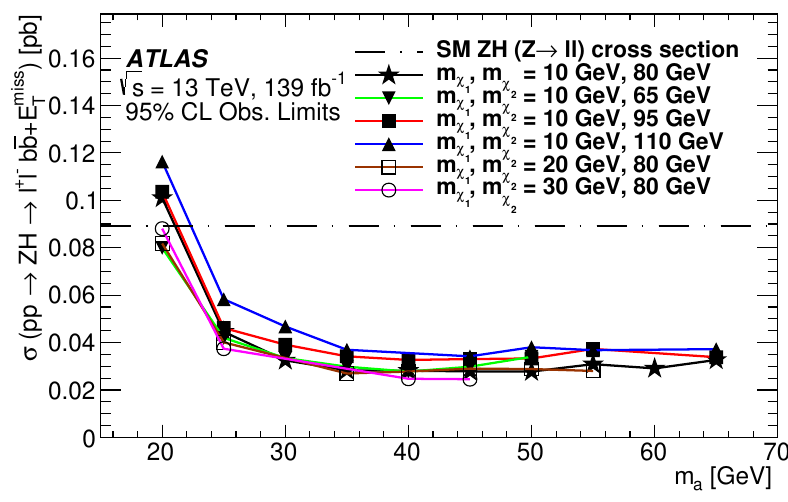
Figure 4. Upper limits at 95% CL on the cross section pp → ZH times branching ratio for 0 0 ¯ ˜ χ 0 ˜ χ 0 ˜ χ 0 ˜ χ 0 as a function of m for Z → ‘ + ‘ − (where ‘ = e, µ or τ ) and H → ˜ χ b ˜ χ 2 1 → a 1 1 → b 1 1 a several values of m and m for the NMSSM scenario described in the text. All branching ˜ χ 0 1 ˜ χ 0 2 ˜ χ 0 ratios in the Higgs boson decay chain after the decay H → ˜ χ 0 are set to 100%. The different 2 1 ranges in m reflect differences in the allowed event kinematics. The lines joining the m points a a come from an assumed linear interpolation of the limits. The SM value for the cross section σ ( pp → ZH ) × BR ( Z → ‘ + ‘ − ) is shown for